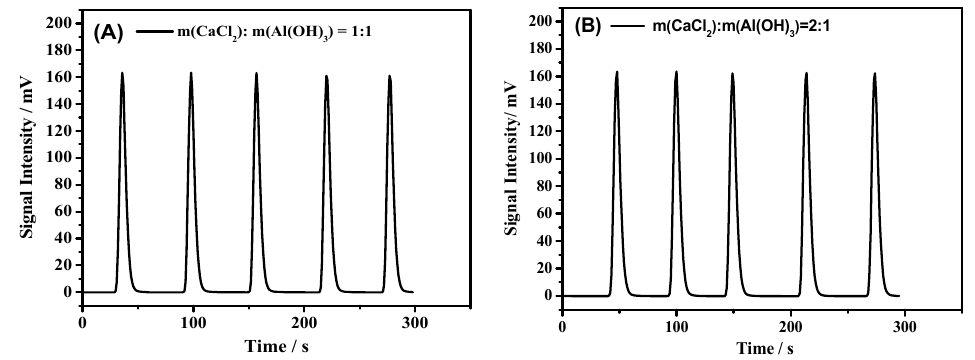
Figure 4. Adsorption performance of HF adsorbents on C 4 F 7 N , ( A ) NaF, ( B ) CaF 2 , ( C ) MgF 2 , ( D ) Al(OH) 3 .